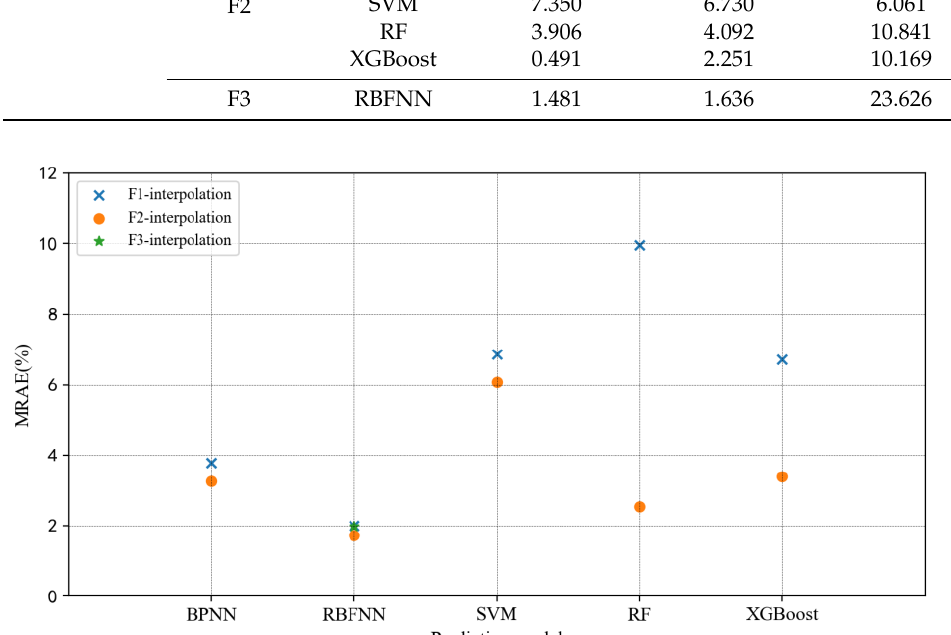
Figure 8. The Maximum of Relative Absolute Error ( MRAE) of interpolation prediction under different models.